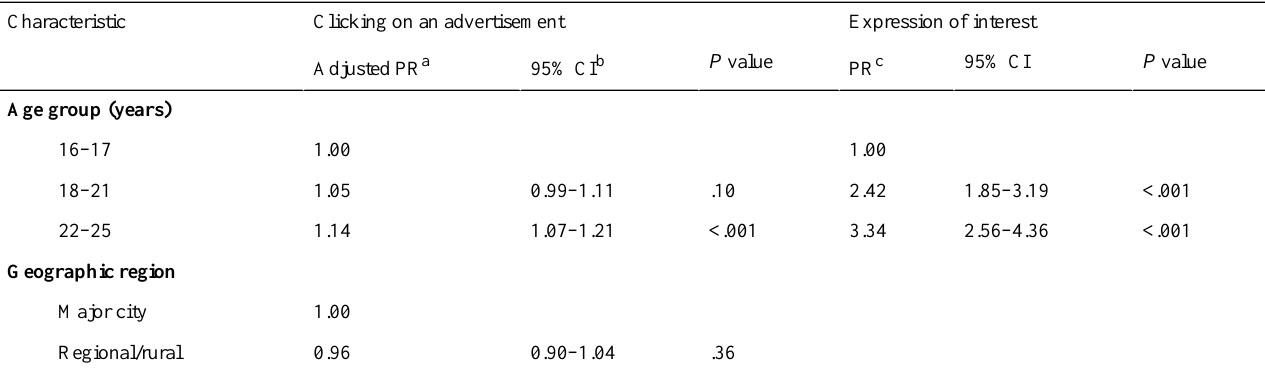
Table 1. Prevalence ratios of clicking on the Facebook advertisement and submitting an expression of interest